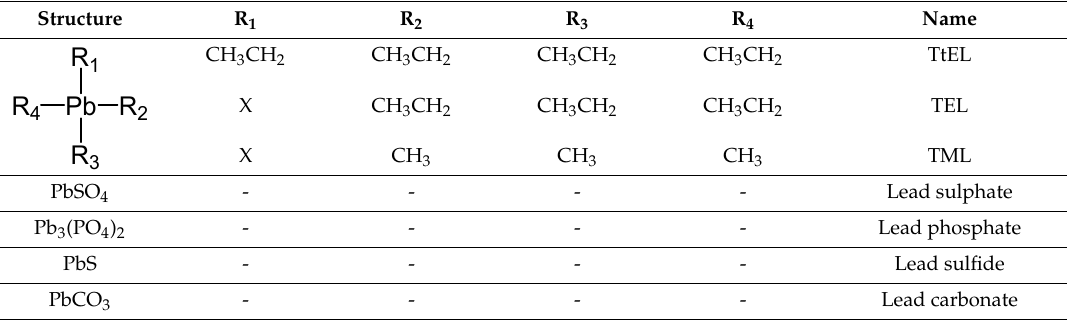
Table 1. Lead compounds toxicologically relevant. TtEL—tetraethyllead, TEL—trimethyl lead, TML—trimethyl lead, X -halide (Cl).